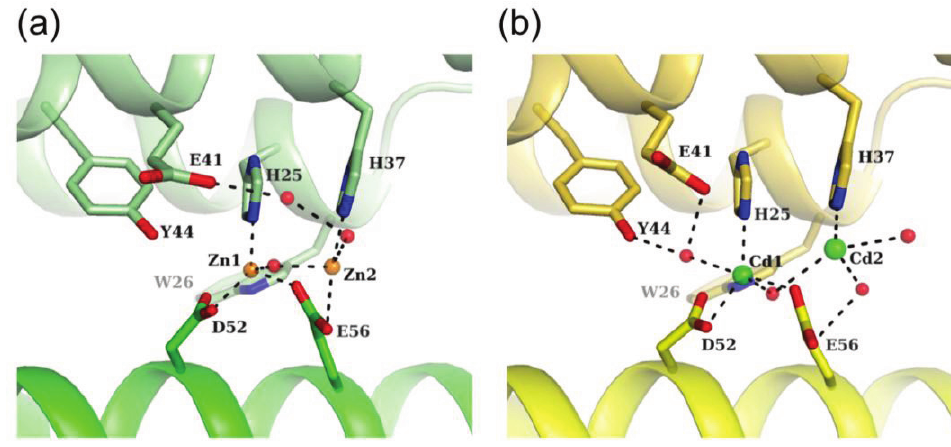
Figure 5. Close-up views of the ferroxidase center. ( a ) Zn-loaded HP-NAP YS39 (PDB ID: 4EVB). Zinc and water molecules are shown as orange and red spheres, respectively. Dashed lines indicate coordinate bonds or hydrogen bonds; ( b ) Cd-loaded HP-NAP YS39 (PDB ID: 4EVC). Cadmium and water molecules are shown as green and red spheres,